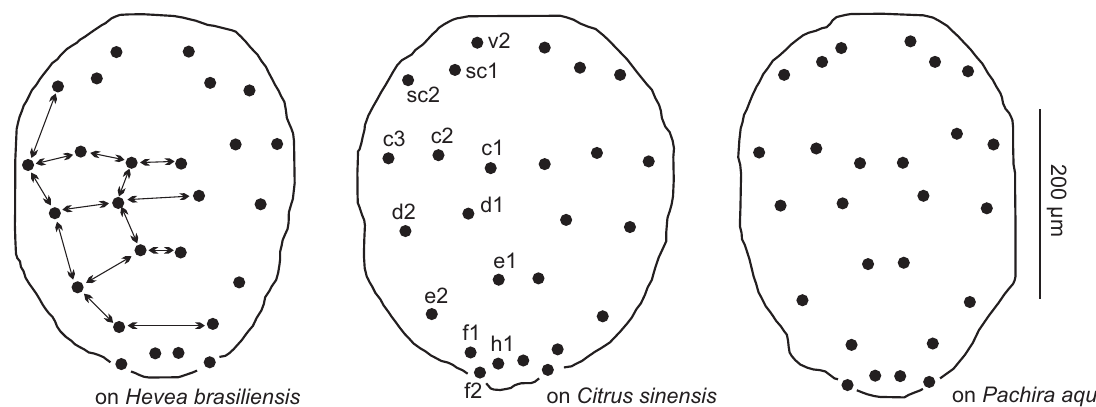
Figura 24. Padrão de distribuição das setas dorsais do idiossoma de fêmeas de E. banksi oriundas de H. brasiliensis , Citrus sp. e P. aquatica (DZSJRP, nº 6767, 6632 e 6574, respectivamente). Distâncias entre elementos dos pares de setas: sc2-c3 , c1-c1 , c1-c2 , c2-c3 , c1-d1 , d1-